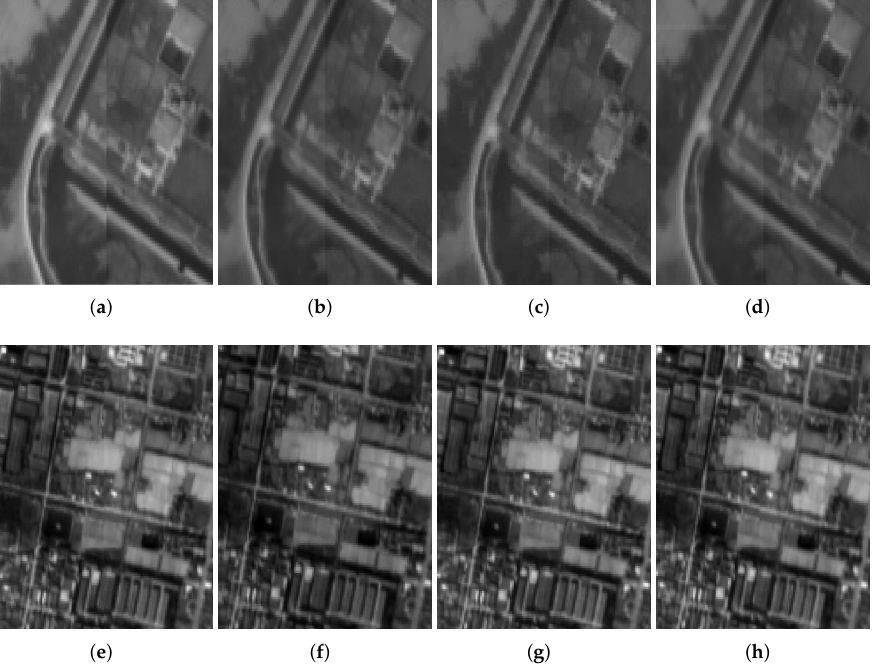
Figure 12. Stitching results for Image Data 1 with different methods: ( a ) traditional line-time normal- ization, ( b ) line-based line-time normalization, ( c ) block-based line-time normalization, ( d ) scene- based line-time normalization, ( e ) traditional line-time normalization, ( f ) line-based line-time normal- ization, ( g ) block-based line-time normalization, ( h ) scene-based line-time normalization.